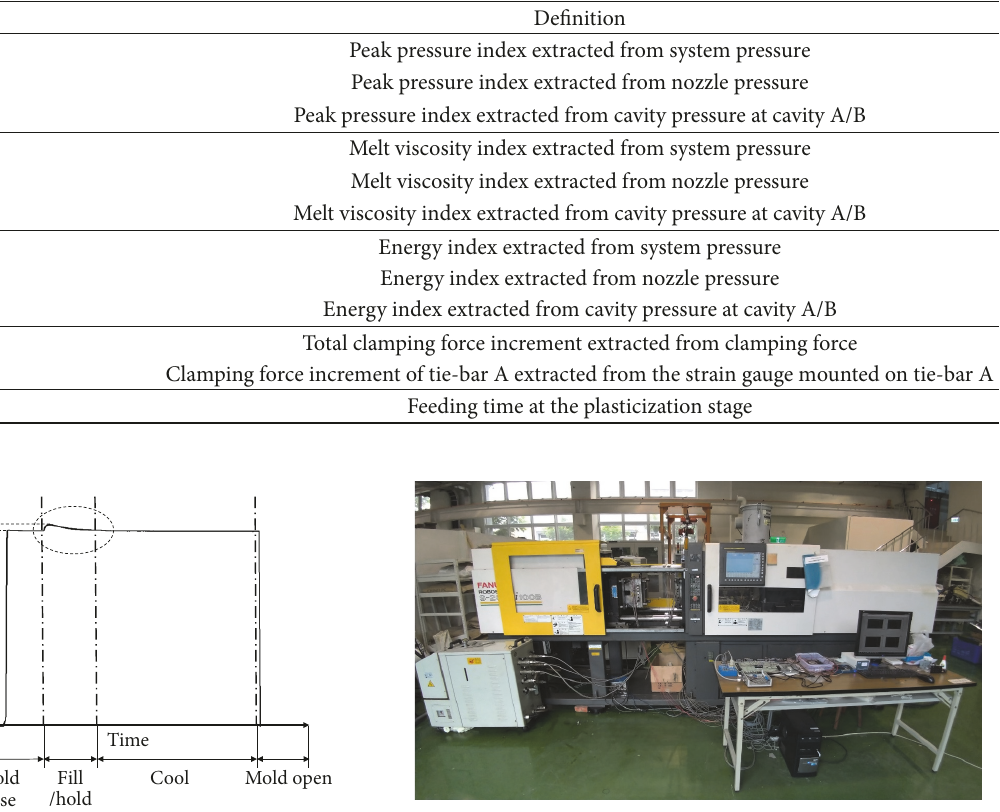
Figure 3: Clamping force increment index.